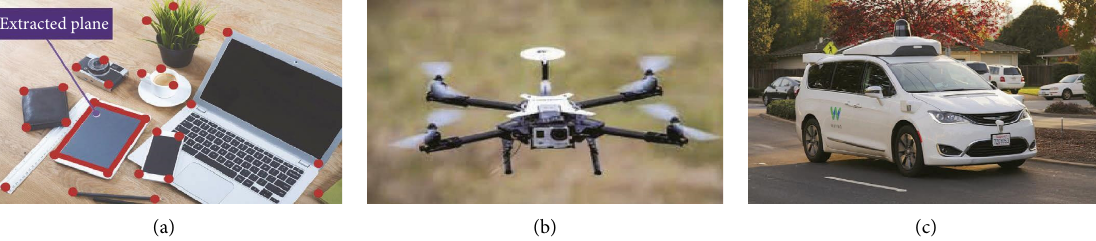
Figure 1: Research and application of V-SLAM samples: (a) the application in the feature detection, (b) the application in aircraft, and (c) the application in the feld of autonomous driving.